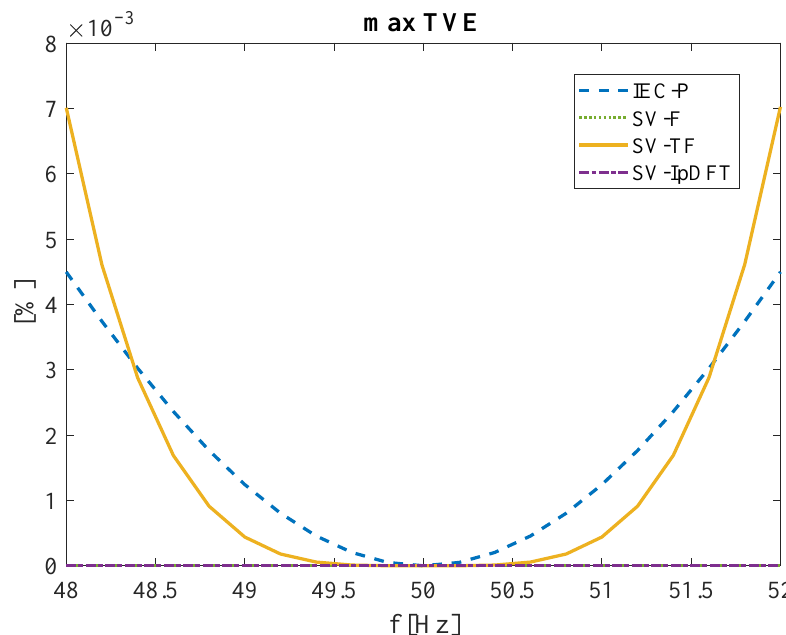
Figure 5. Maximum TVE results under off-nominal frequency